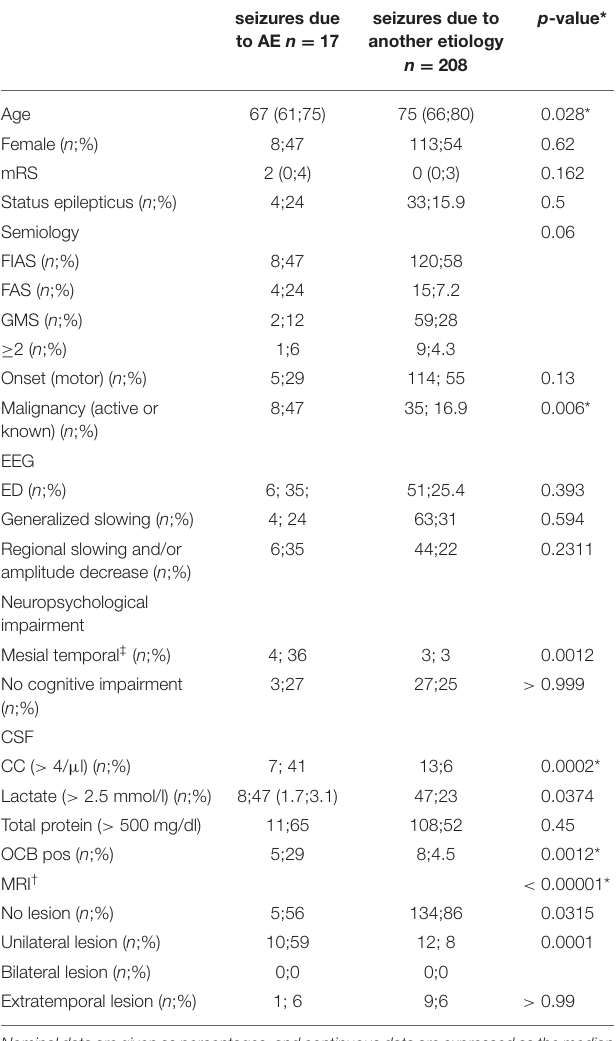
TABLE 4 | Comparison of clinical characteristics between AE cohorts and cohort III.